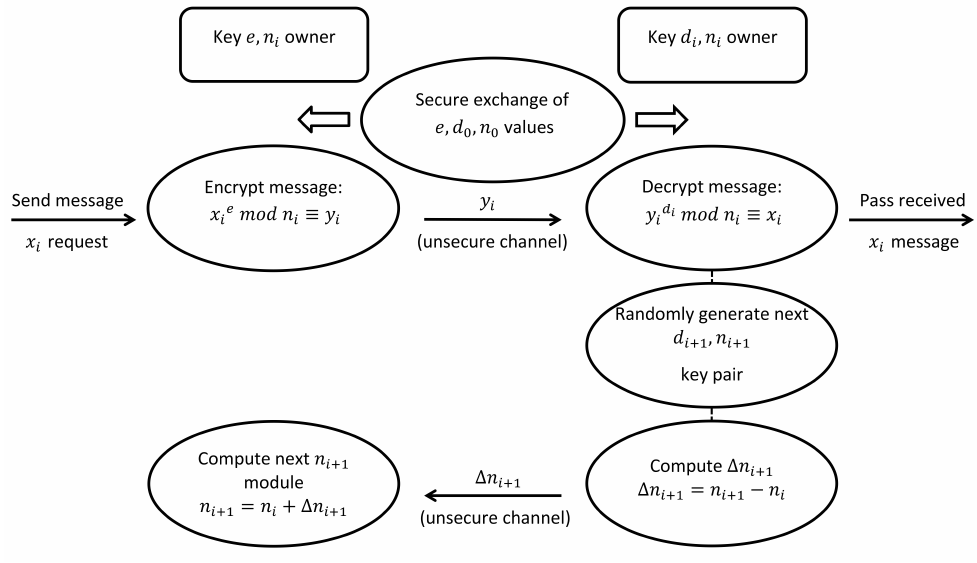
Figure 1. RSA-OTP scheme.